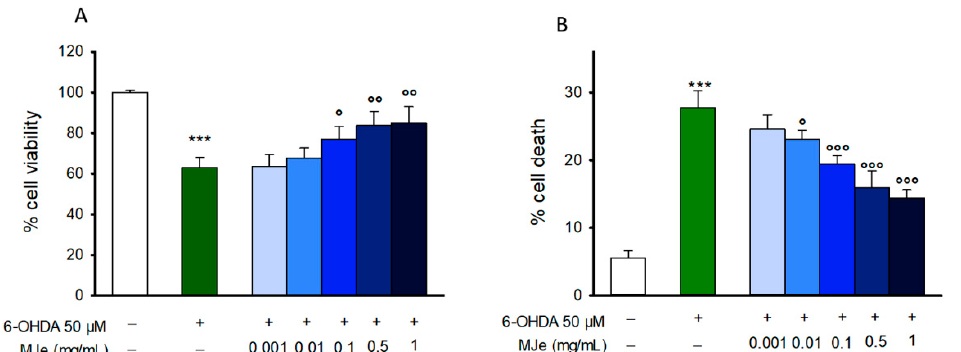
Figure 2. Protective effect of mandarin juice extract (MJe) against 6-hydroxydopamine (6-OHDA)-induced cytotoxicity. Cell viability was detected with the 1-(4,5-dimethylthiazol-2-yl)-3,5-diphenylformazan (MTT) assay ( A ). The viability variation was calculated as percentage of viable cells in treated cultures relative to those in untreated ones. Cell death was estimated by the trypan blue (TB) assay and expressed as percentage of nonviable (blue stained) cells relative to total counted cells ( B ). Results are displayed as mean ± standard error of the means (SEM) from three independent experiments in eight replicates (MTT; N = 24) or in triplicate (TB; N = 9). *** p < 0.001 vs. ctrl; ◦ p < 0.05, ◦◦ p < 0.01 and ◦◦◦ p < 0.001 vs. 6-OHDA 50 µ M.